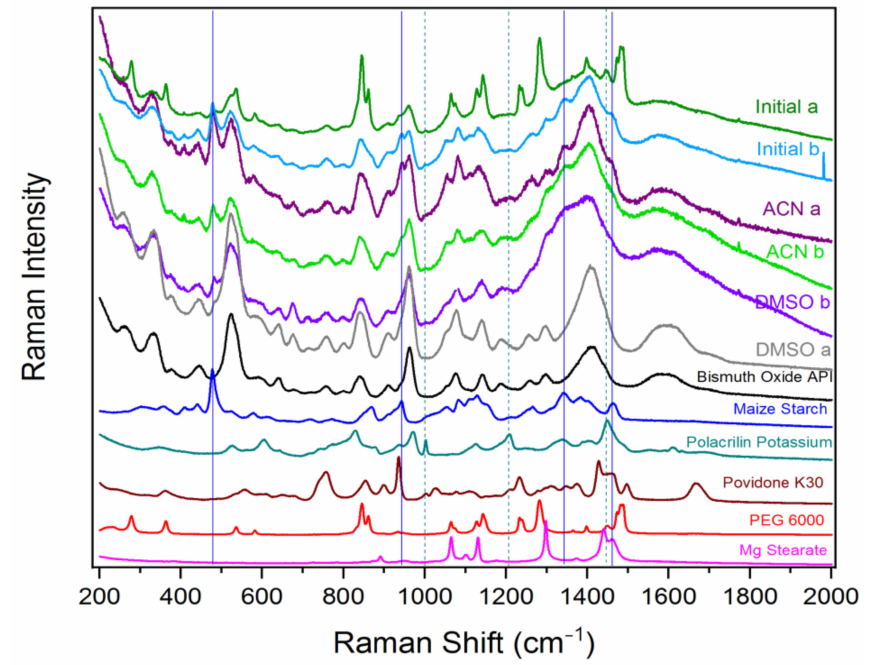
Figure 3. Raman spectra of bismuth oxide API, excipients, initial tablet, tablet dispersed in acetonitrile, and tablet further dispersed and centrifuged in heated